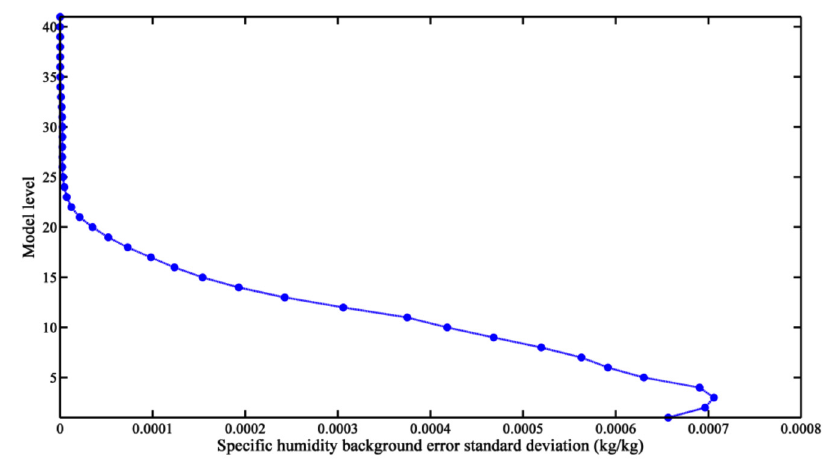
Figure 6. Vertical profile of specific humidity background error standard deviation at Tehran Mehrabad airport station. The profile is ob- tained from WRF 3DVAR single observation test in model